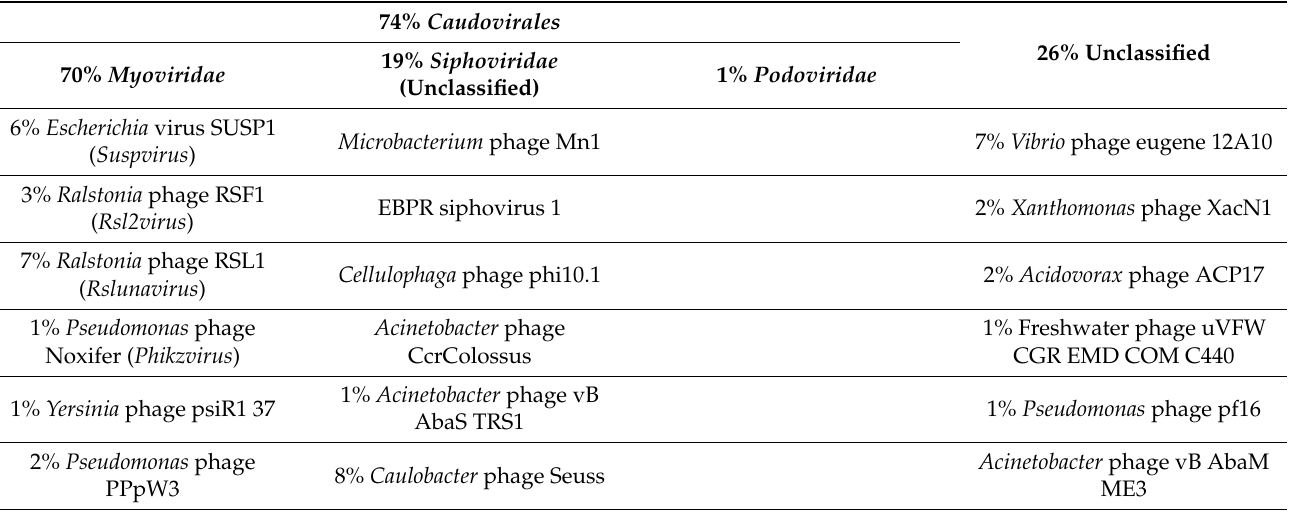
Table 5. Bacteriophage detection using shotgun metagenomic